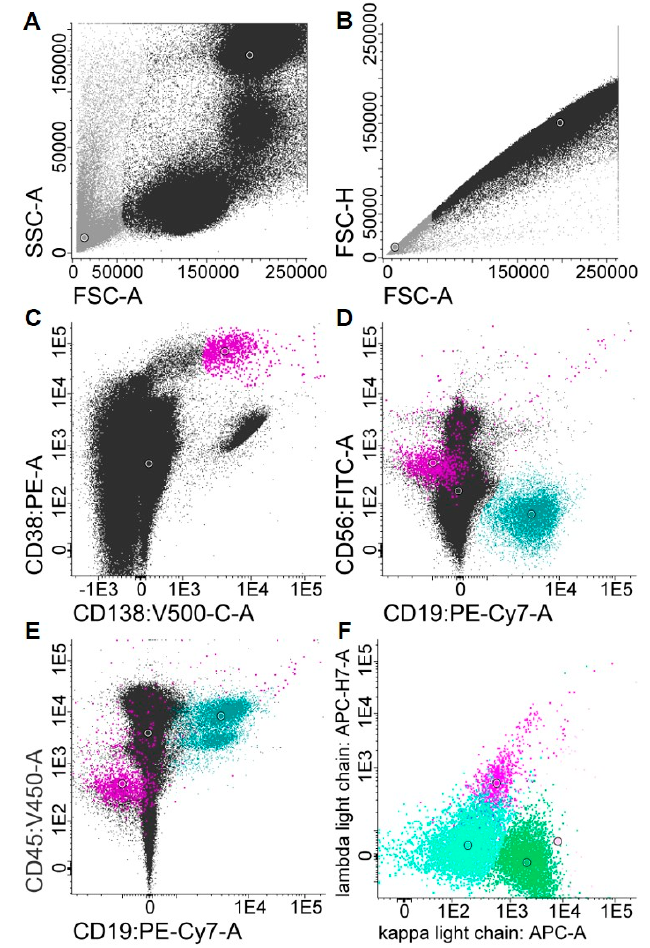
Figure 6. Gating strategy for the identification of aberrant plasma cells. After exclusion of debris (gray, A ) and duplets (gray, B ), plasma cells are defined as the CD38- and CD138-positive population (purple, C ) among the leukocytes (black). Aberrant plasma cells are usually CD56-positive, CD19-low and CD45-low ( D , E ). Moreover, aberrant plasma cells show light chain restriction (in this case, lambda, F ). Non-aberrant plasma cells do not display a light chain restriction, similar to B-cells (green) that display a regular distribution with regard to the kappa and lambda light chains ( F ). Gating was performed with Infinicyt Flow Cytometry Software. SSC-A, side scatter area; FSC-A, forward scatter area; FSC-H, forward scatter height.